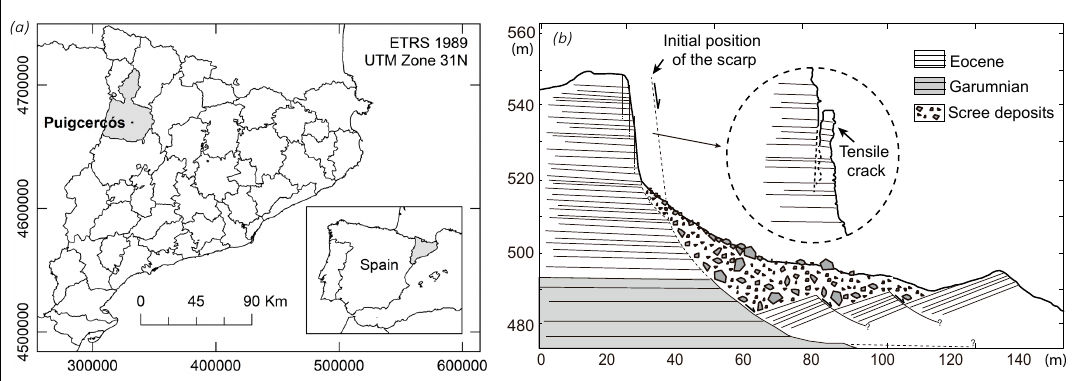
Figure 4. ( a ) Puigcerc ó s location (Pallars Juss à —Catalonia—NE Spain). ( b ) Geomorphological scheme of the Puigcerc ó s cli ff and main rockfall mechanism (modified from Roy á n et al.